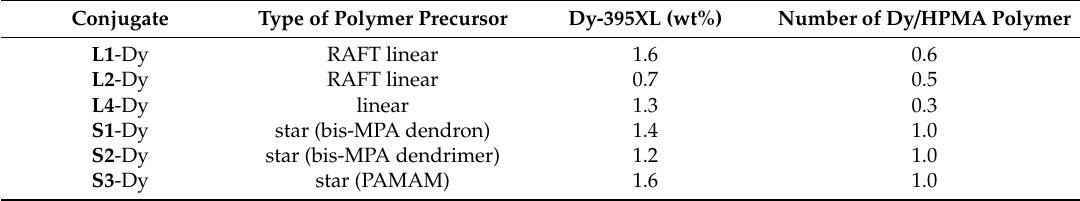
Table 3. List of fluorescently labeled HPMA polymer systems and their characteristics.